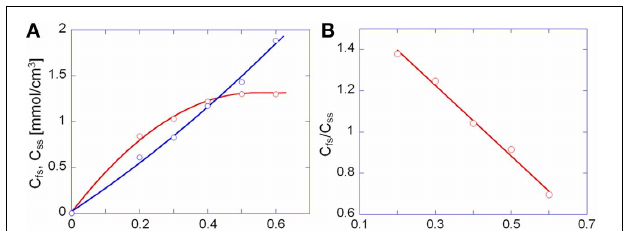
Figure 8 | Difference spectra in the ν (OH)— ν (CH) region (4000–2400cm − 1 ) of PMDA-ODA films equilibrated at different relative pressures of methanol vapor. Color code: red trace: p / p 0 = 0 . 2; blue trace: p / p 0 = 0 . 3; cyan trace: p / p 0 = 0 . 4; green trace: p / p 0 = 0 . 5; black trace: p / p 0 = 0 . 6. The absorbance scale refers to the red trace; the other spectra were normalized with respect to the peak at 3580cm − 1 to facilitate the comparison.